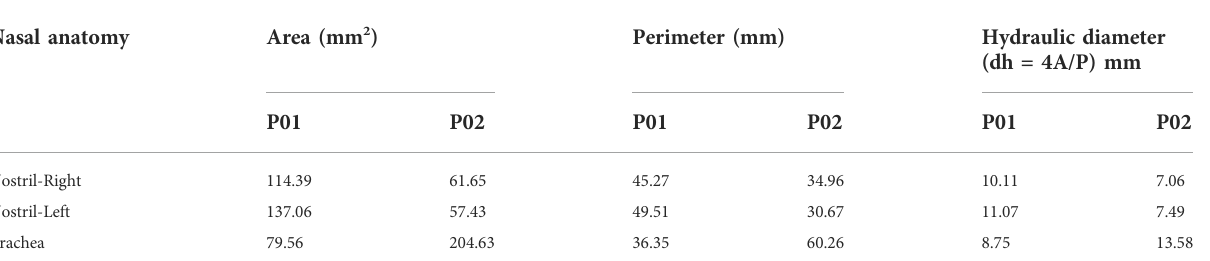
TABLE 3 Hydraulic diameter.